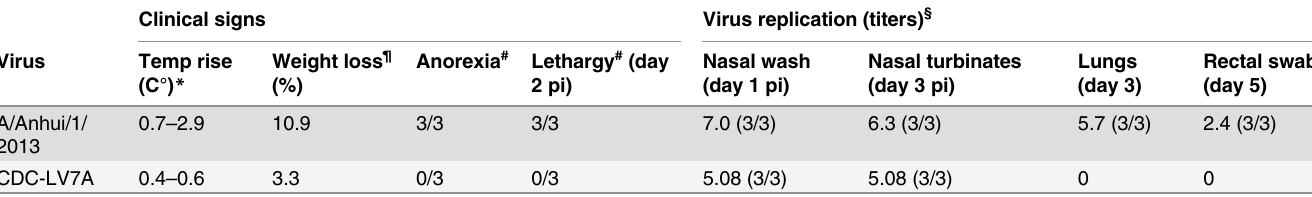
* Temperature increase (range) over baseline during the fi rst 10 days pi. ¶ The percentage mean maximum weight loss observed during the fi rst 10 days post infection (pi)